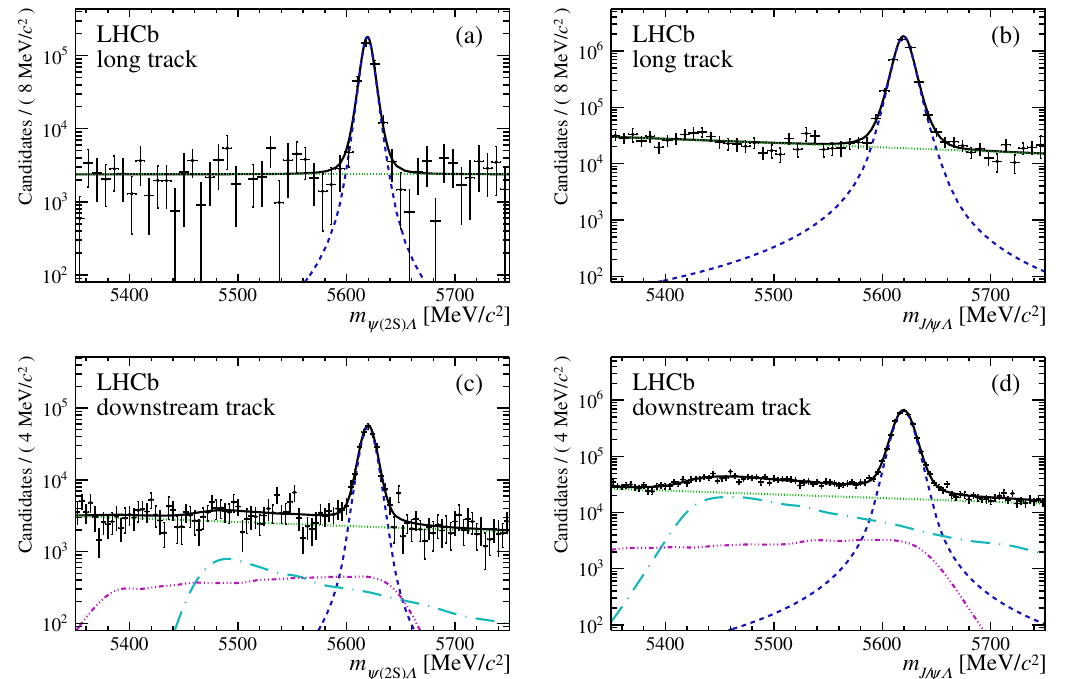
! b ! (2 S ) (cid:3) and (d) b ! (cid:4) (cid:0) background (violet, b